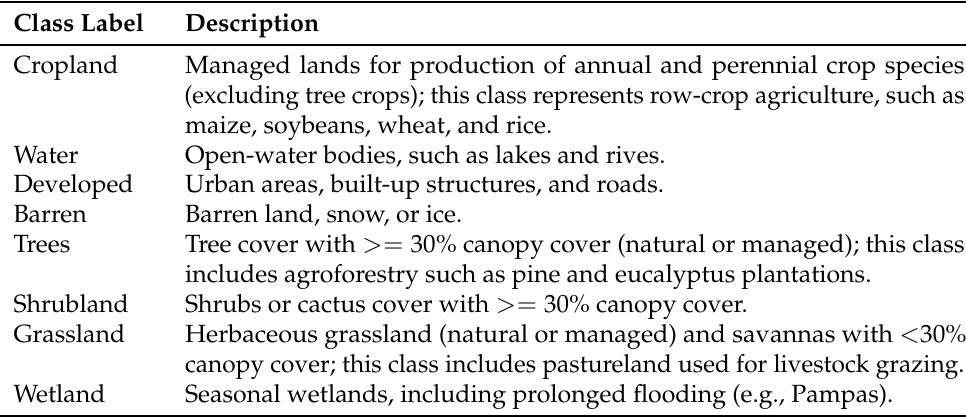
Table 1. Land cover classes and definitions.